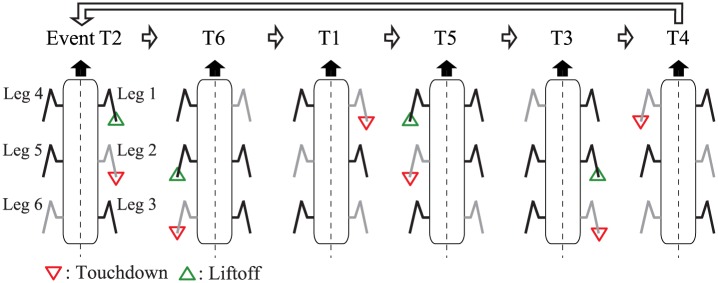
Touchdown and liftoff events for the direct wave gait.Black and grey legs represent the stance and swing legs, respectively. Events Ti and T(i + 3) (i = 1, 2, 3) have axial symmetry.